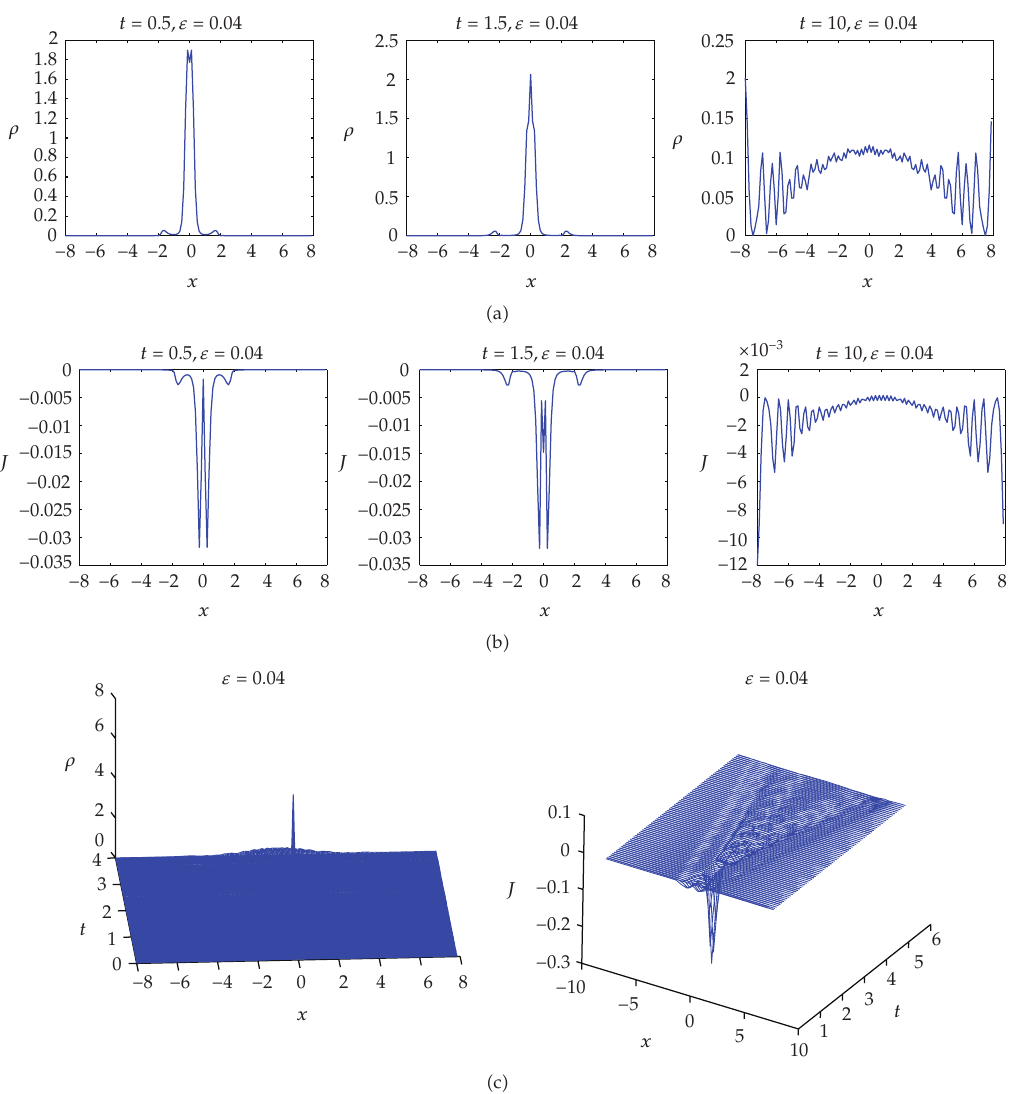
Figure 6: Numerical solutions of Example 5.2 by ED2/EP2 for the weak O (cid:3) ε 3 / 2 (cid:4) defocusing nonlinearity (cid:3) ε (cid:6) 0 . 04 (cid:4) . (cid:3) a (cid:4) Position density ρ at t (cid:6) 0 . 5 (cid:3) before breaking (cid:4) , at t (cid:6) 1 . 5 (cid:3) after breaking (cid:4) , at t (cid:6) 10. (cid:3) b (cid:4) Current density J at t (cid:6) 0 . 5 (cid:3) before breaking (cid:4) , at t (cid:6) 1 . 5 (cid:3) after breaking (cid:4) , at t (cid:6) 10. (cid:3) c (cid:4) Evolution of the position density ρ (cid:3) left (cid:4) and the current density J (cid:3) right (cid:4) .